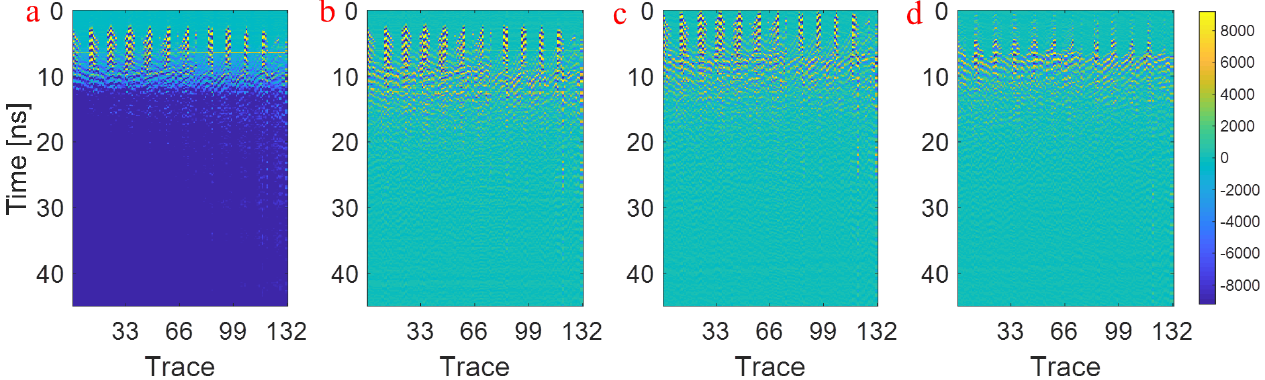
Figure 4. The preprocessing results. ( a ) The raw data. ( b ) Remove the DC component by band-pass filter. ( c ) Channel delay correction. ( d ) The result of eliminating the clutters interference.